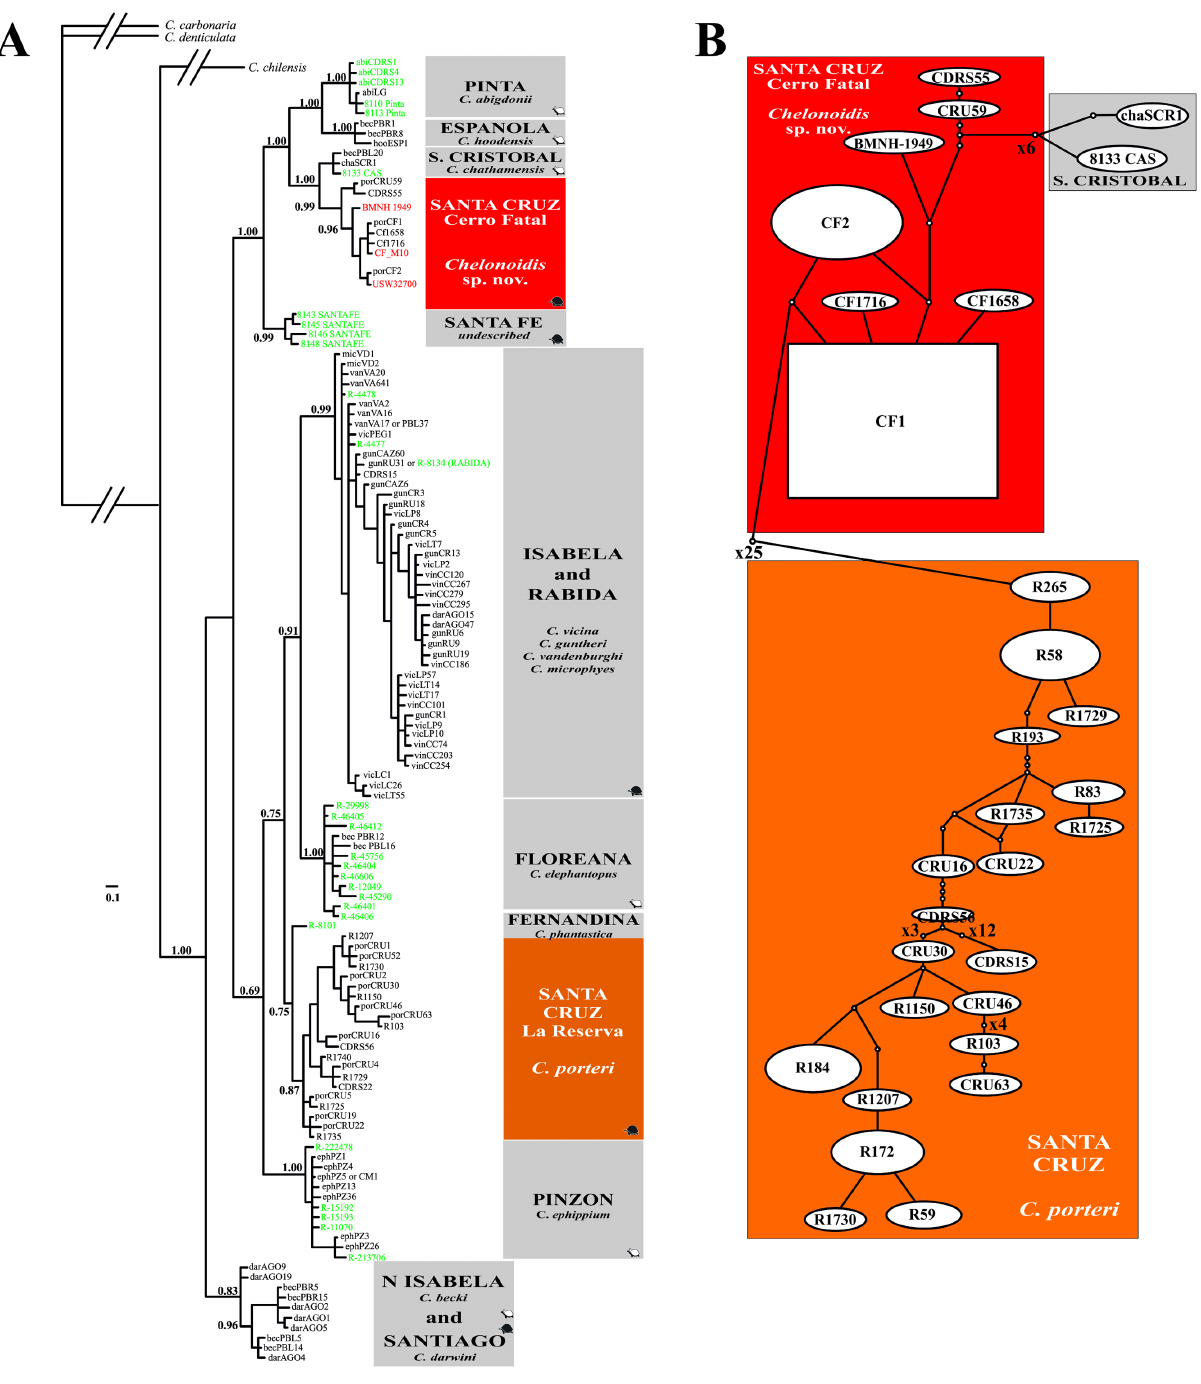
Fig 2. (A) Bayesian Inference (BI) tree reconstructed from the dataset including all unique mtDNA control region haplotypes previously sampled from extant and extinct species as well as the three museum specimens of giant Galapagos tortoises analyzed in this study. Numbers on branches indicate posterior probabilities. Only the nodal support values for the major lineages are presented. Red and green colors identify museum samples analyzed in the present and previous studies, respectively. ( B) Haplotype network showing matrilineal diversity recovered from 70 sequences of C . porteri from Reserva, 51 sequences of the lineage from Cerro Fatal, and 2 sequences of C . chathamensis from San Cristóbal Island. Twenty-five inferred mutations separate the haplogroups of Chelonoidis sp. nov. from Cerro Fatal from the ones from C . porteri from